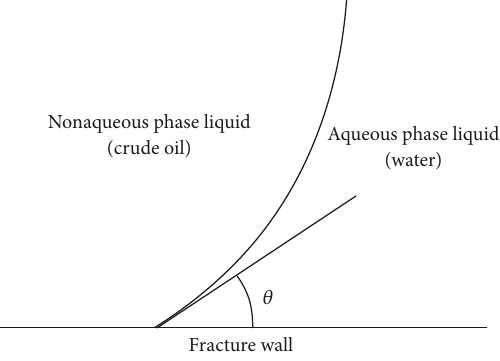
Figure 4: Definition of the contact